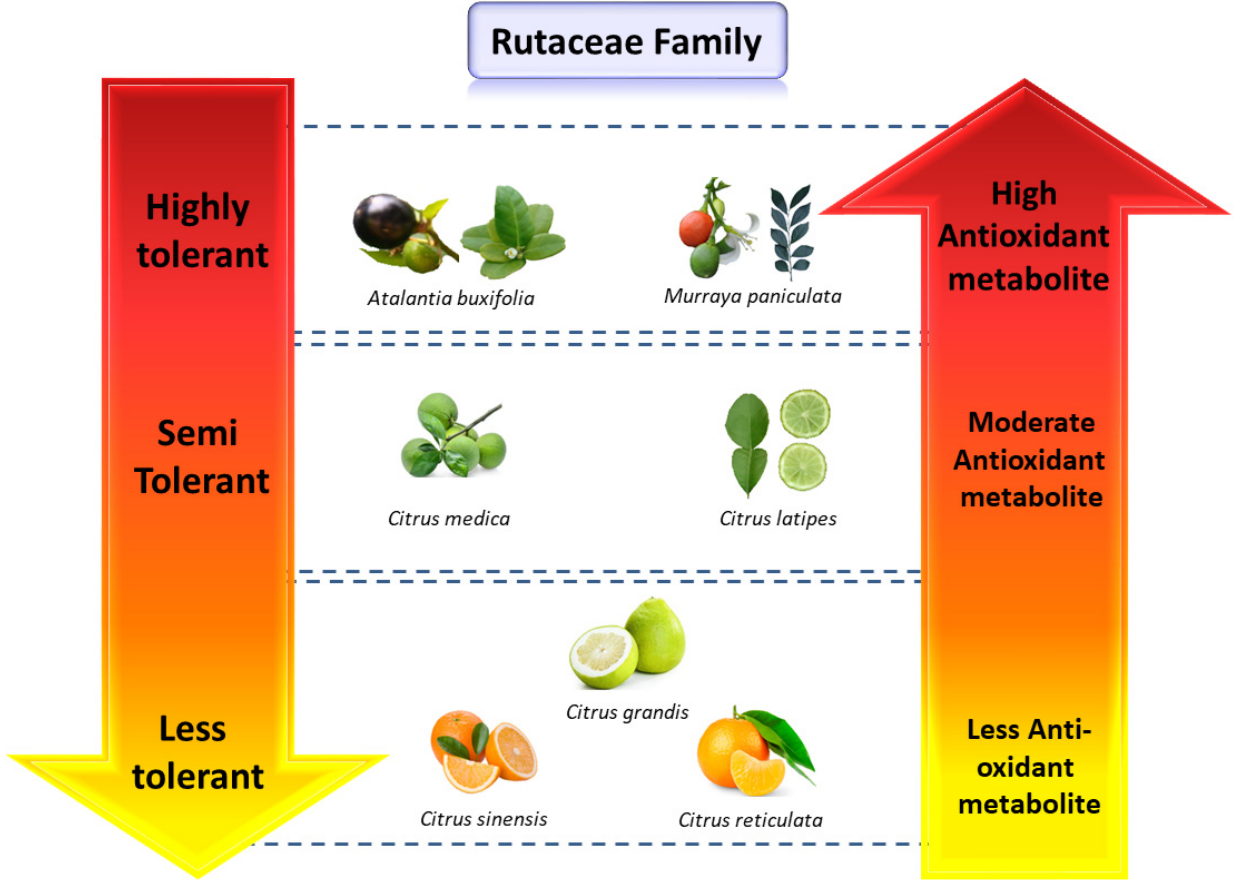
Figure 4. Correlation among antioxidant metabolites and stress tolerance in different Citrus species. The primitive citrus species that have a high level of metabolites are tolerant to various abiotic and biotic stresses; the wild citrus species ( C. medica and C. latipes ) possessing moderate levels of metabolites are semi-tolerant to stresses; and the cultivated citrus species that contain fewer metabolites are more prone to stresses. High levels of metabolites are positively correlated with abiotic [13] and biotic stress tolerance in citrus [15].